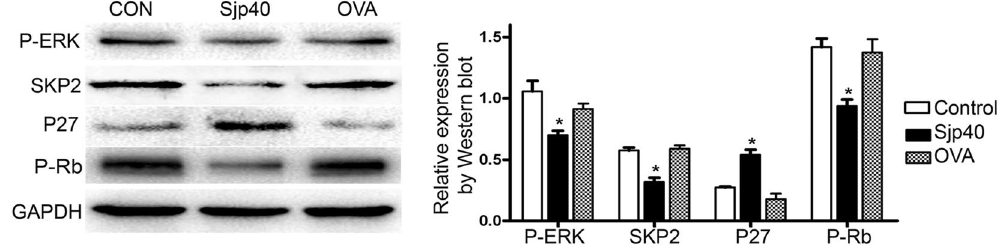
Figure 2. Cellular senescence triggered by Sjp40 is associated with P27 signal pathway. Western blot analysis of the expression levels of P-ERK, SKP2, P27 and P-Rb in LX-2 cells treated with Sjp40. All values were expressed as the mean ± SEM of three or more independent trials. * p < 0.05 compared to control group.